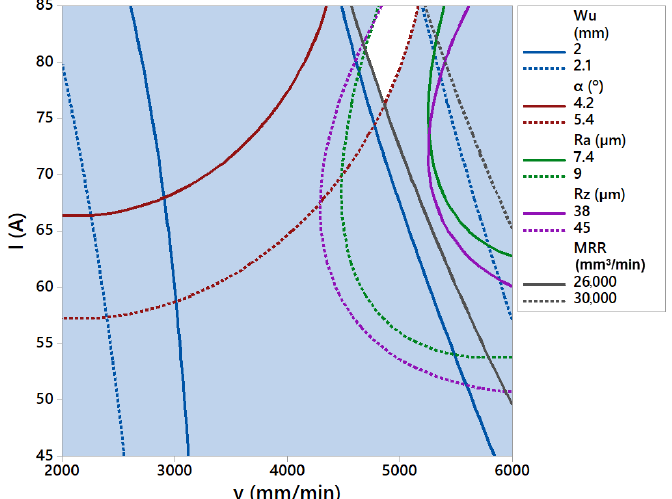
Figure 18. Optimal cutting area (white colored) at H = 1 mm.